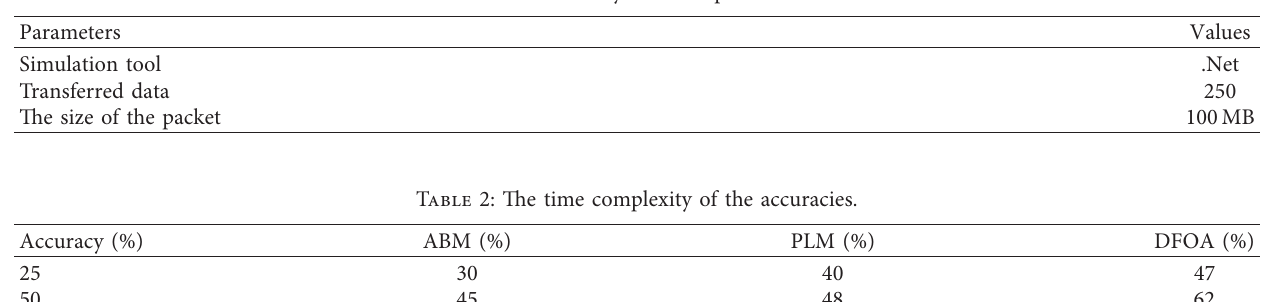
Figure 3: The circuit diagram of the network mapping. Table 1: Analysis of the product.